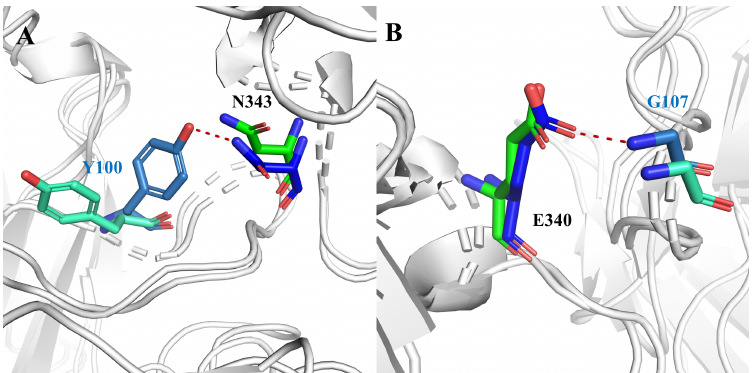
Figure 4. Hydrogen bond changes of GLYCAN and NO-GLYCAN: ( A ) hydrogen bond N343-Y100; ( B ) hydrogen bond G107-E340; blue for GLYCAN antigen RBD; skyblue for GLYCAN antibody S309; green for NO-NOGLYCAN antigen RBD; blue-green for NO-GLYCAN antibody S309.